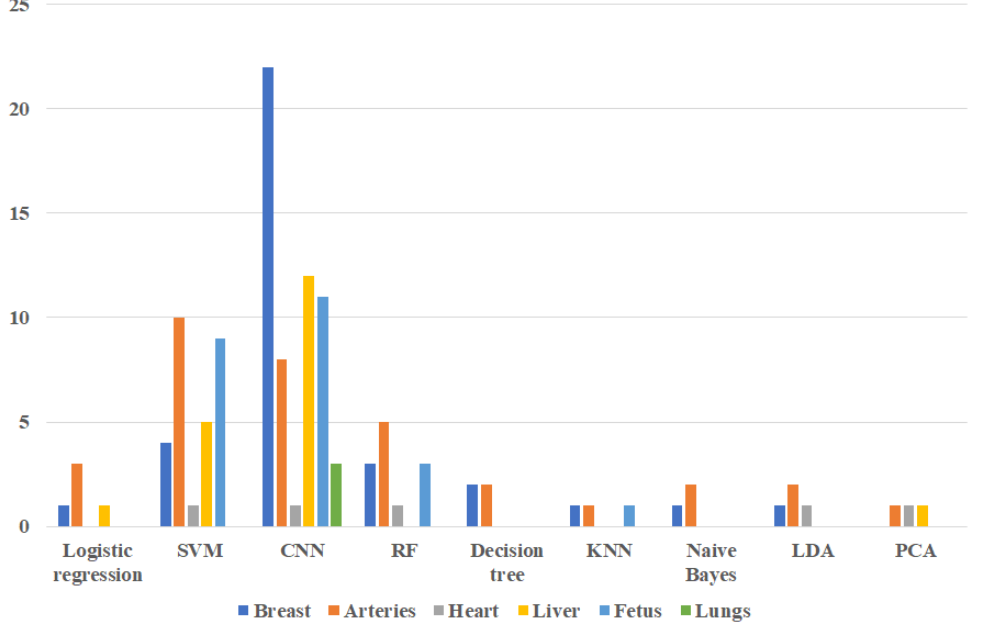
Figure 7. Frequency of ML algorithms application across all